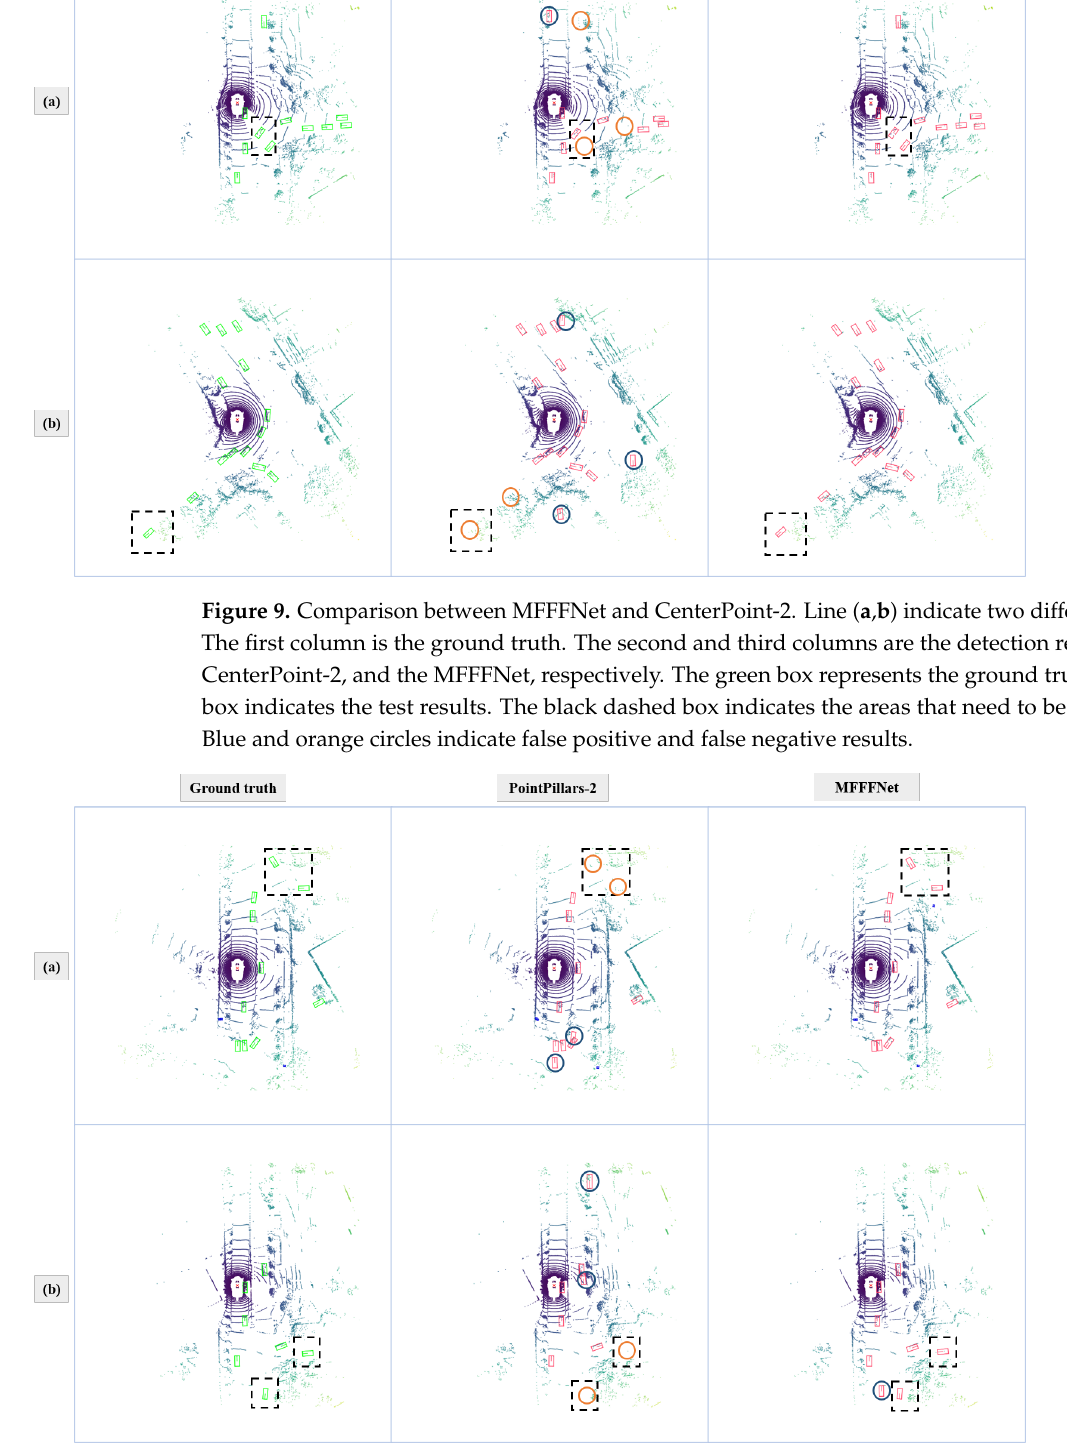
Figure 10. Comparison between MFFFNet and PointPillars-2. Line ( a , b ) indicate two different scenes. The first column is the ground truth. The second and third columns are the detection results of the CenterPoint-2, and the MFFFNet, respectively. The green box represents the ground truth. The red box indicates the test results. The black dashed box indicates the areas that need to be focused on. Blue and orange circles indicate false positive and false negative